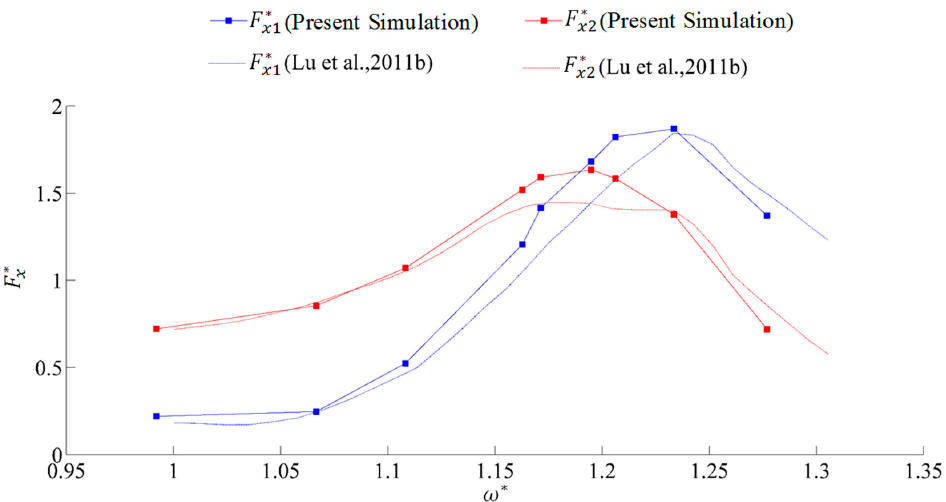
Figure 15. The horizontal force amplitude on SQ1 ( 𝐹 (cid:3051)(cid:2869)∗ ) and SQ2 ( 𝐹 (cid:3051)(cid:2870)∗ ) versus the incident wave frequency 𝜔 ∗ ( 𝐵 (cid:3034) ∗ = 0.1 ) in both the present numerical simulation and numerical results from Lu et al. [18].